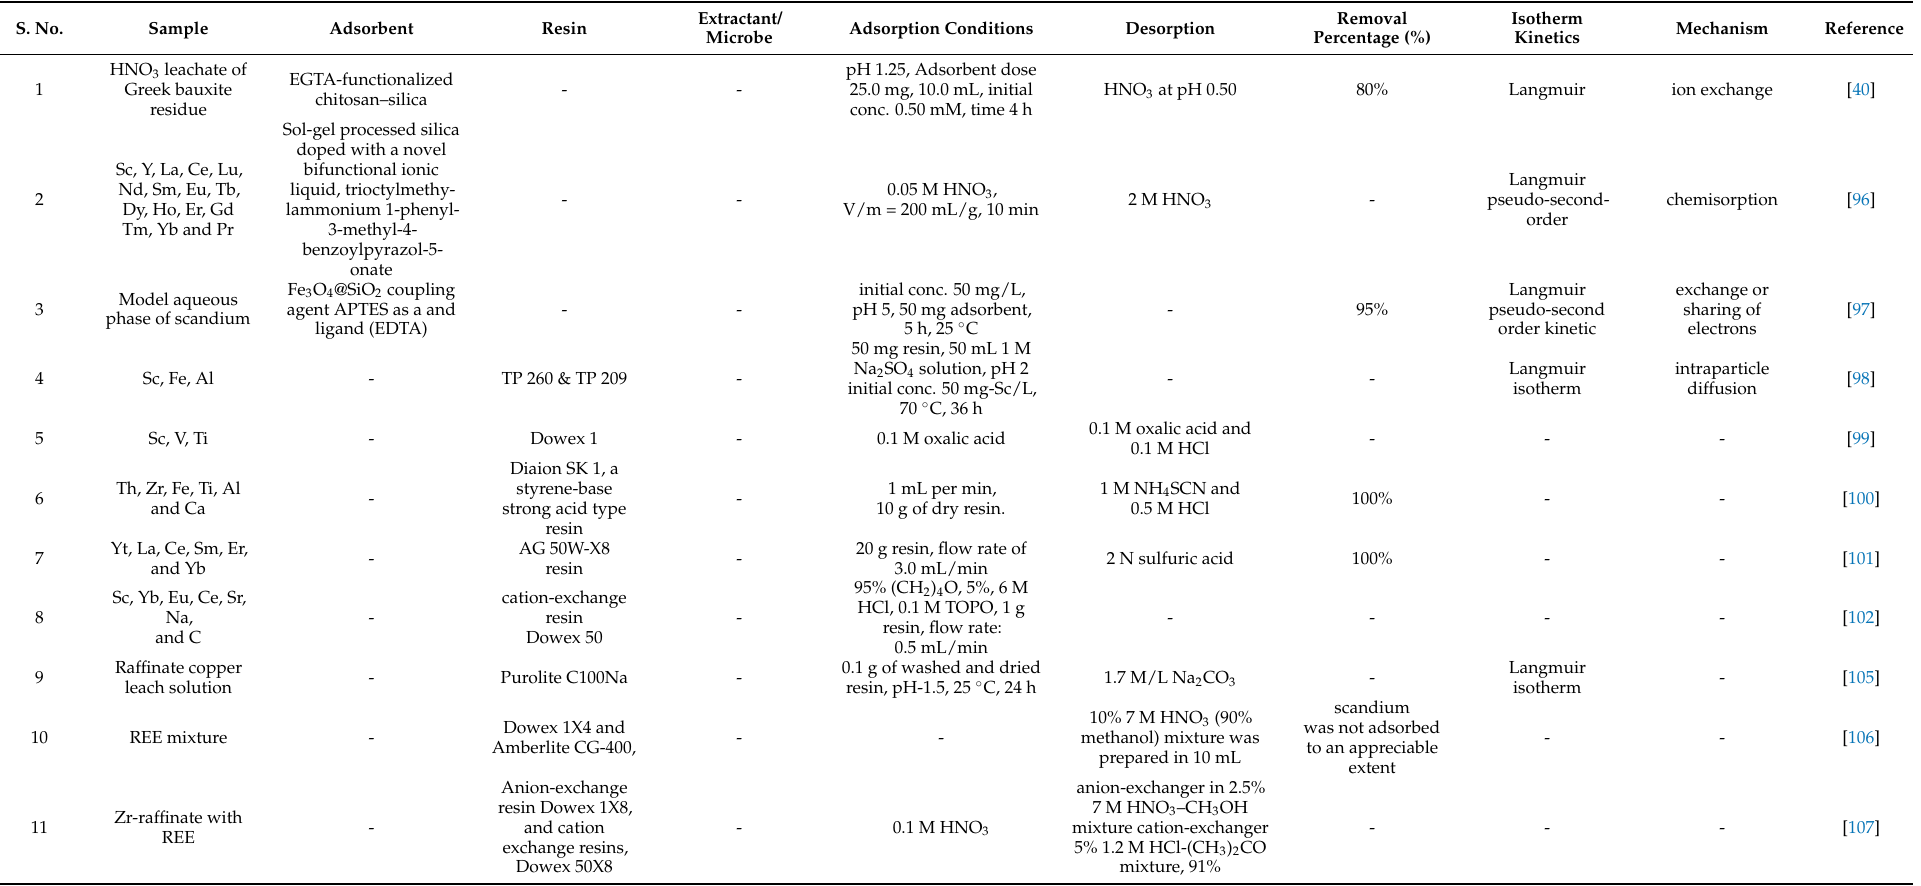
Table 6. Summary of different kinds of adsorbent used for recovery of